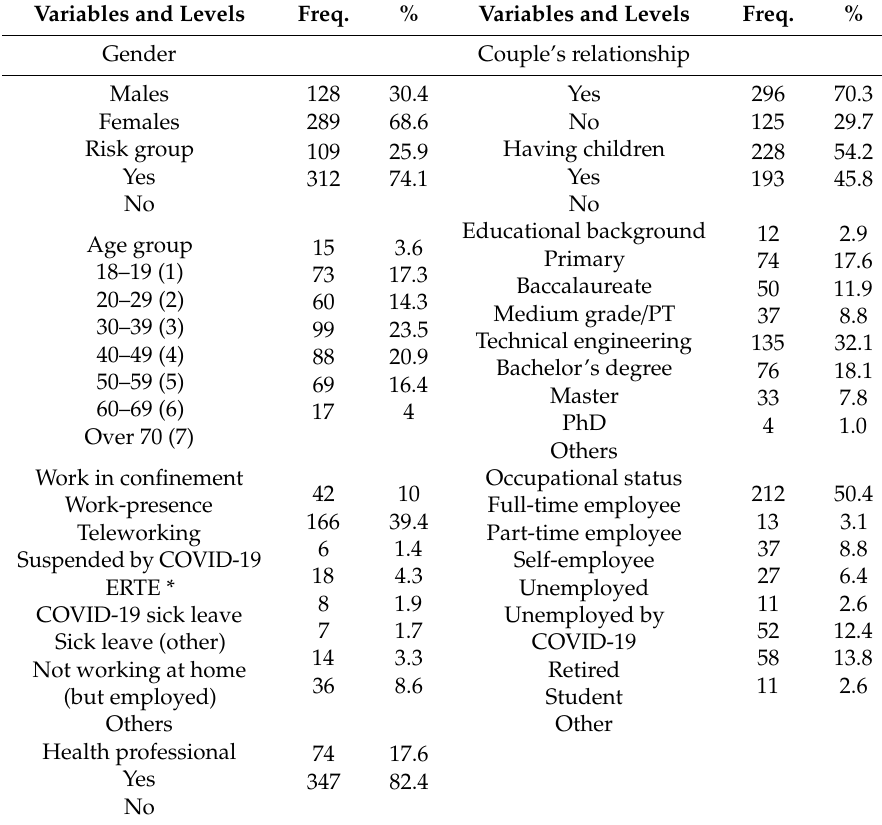
Table 1. Frequencies and percentages of the socio-demographic variables considered. Variables and Levels Freq. % Variables and Levels Freq. % Gender Couple’s